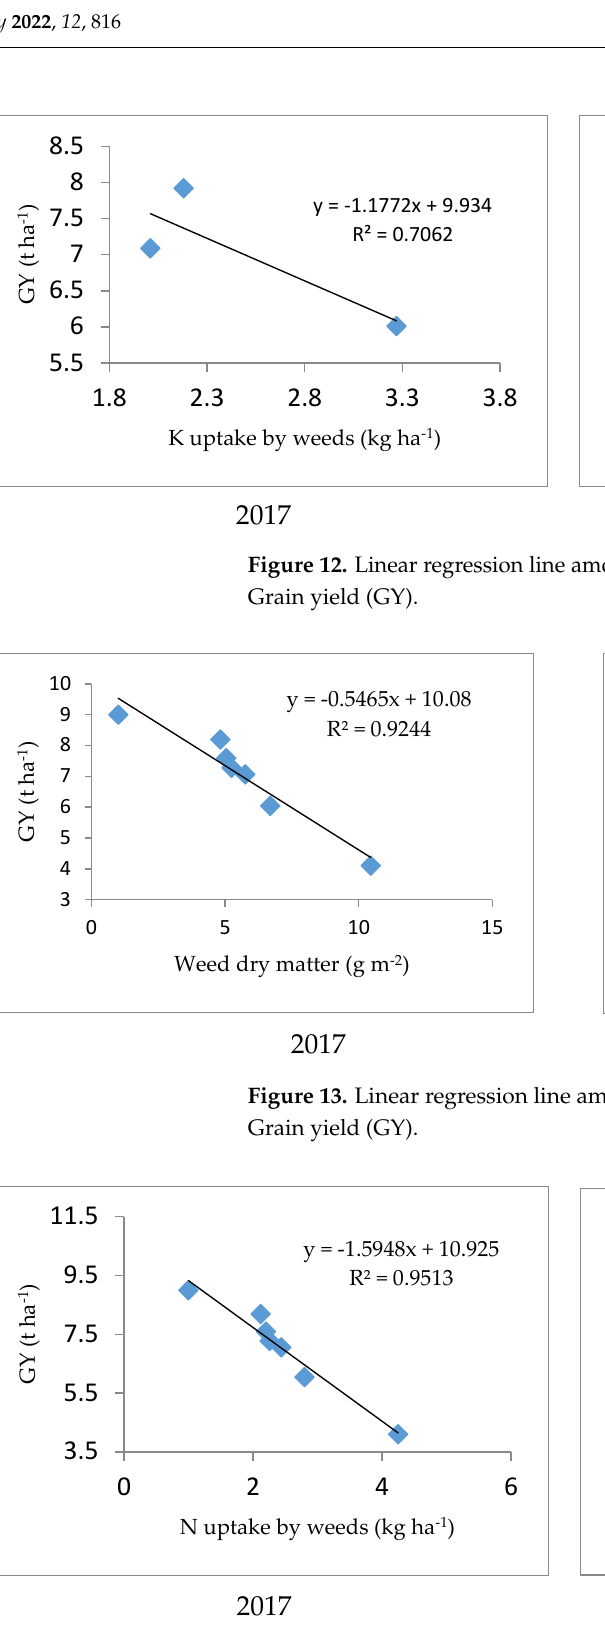
Figure 14. Linear regression line among weed control measures between N-uptake by weeds vs. Grain yield (GY).